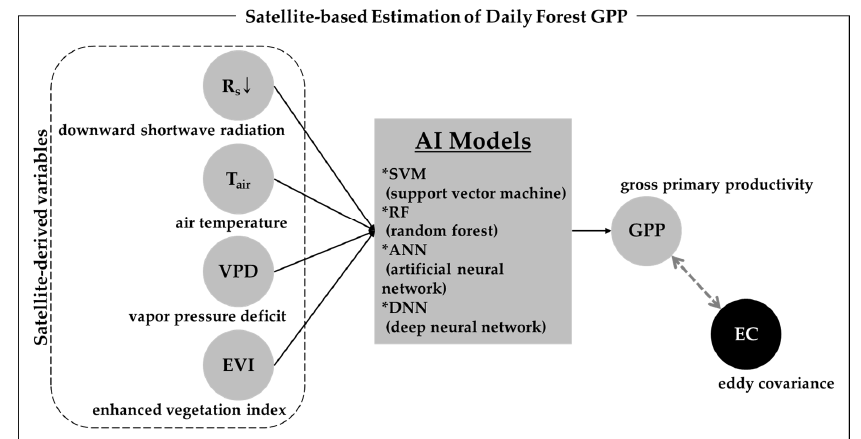
Figure 2. Summary of the data used in this study. Input variables were the satellite data such as downward shortwave radiation (R s ↓ ), air temperature (T air ), vapor pressure deficit (VPD), and enhanced vegetation index (EVI). Gross primary productivity (GPP), the output value, was adjusted using the in-situ observations from the eddy covariance (EC) flux